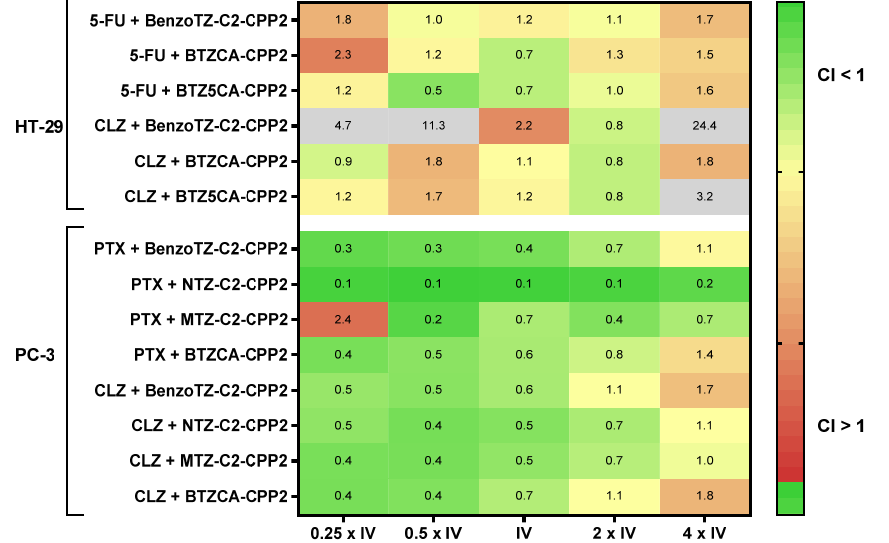
Figure 13. Synergy heat map compiling the CI values in both cell lines treated with the combination of CPP2–thiazole derivates plus the reference drug or CLZ. The squares in the figure indicate antagonism (CI > 1.2, red), additivity (0.9 < CI < 1.1, yellow) and synergism (CI < 0.9, green).